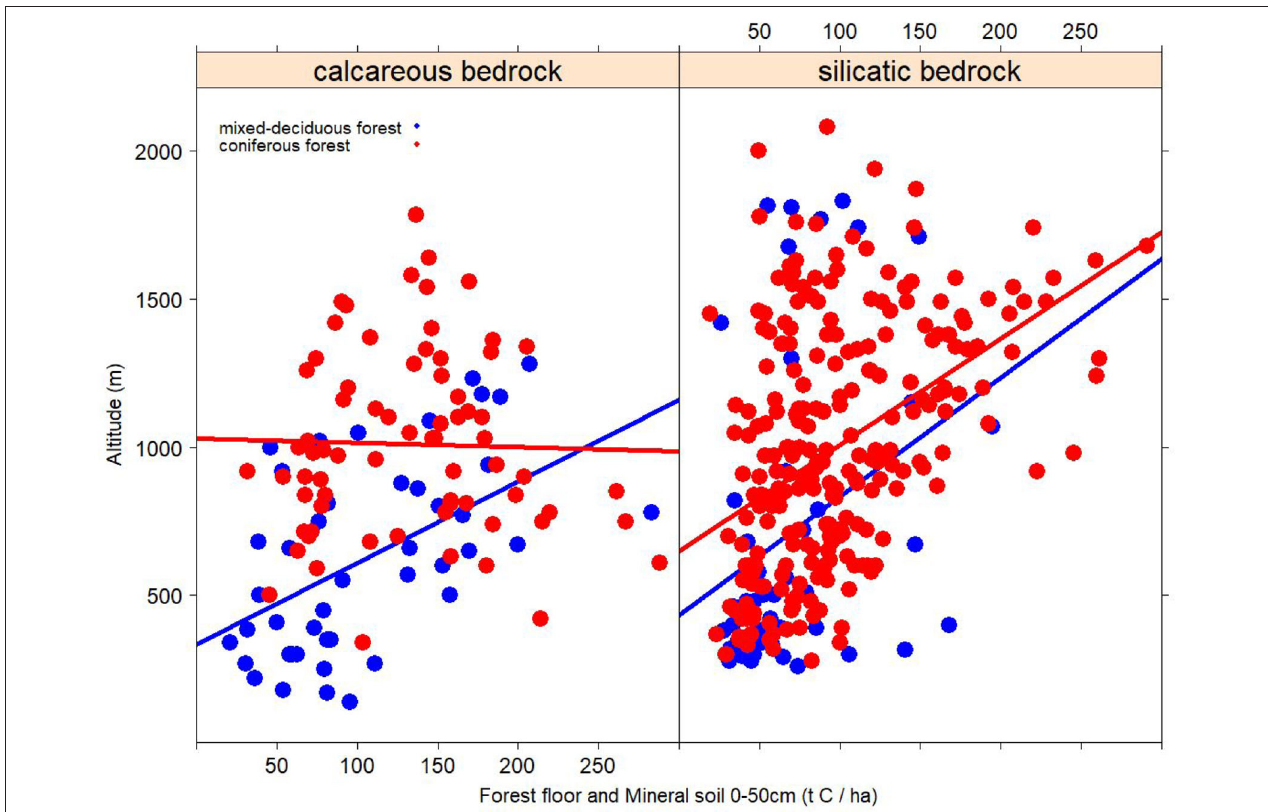
FIGURE 3 | The total soil organic carbon stock differentiated between sites on calcareous bedrock and silicatic bedrock. The elevational gradient is indicated by a linear trend line. Different forest types (coniferous vs. mixed-deciduous forests) are shown in different